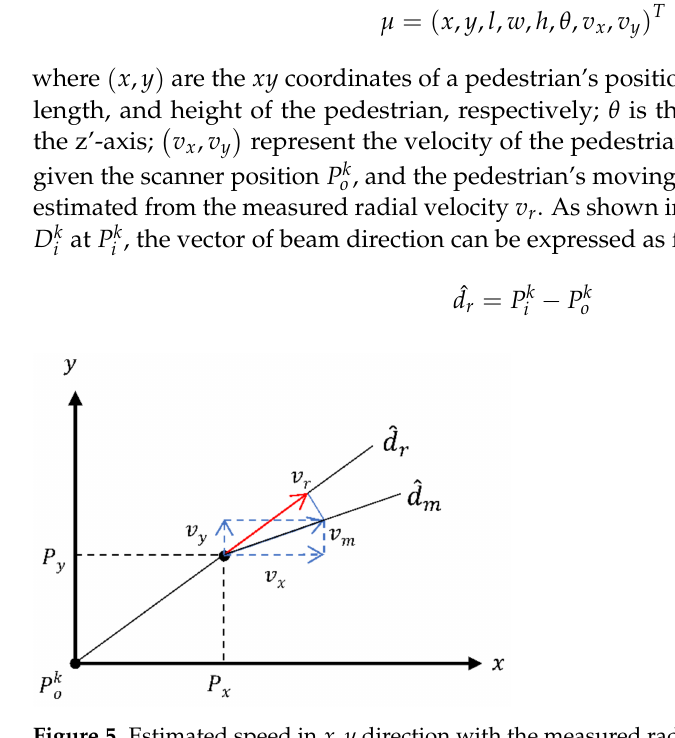
Figure 5. Estimated speed in x , y direction with the measured radial